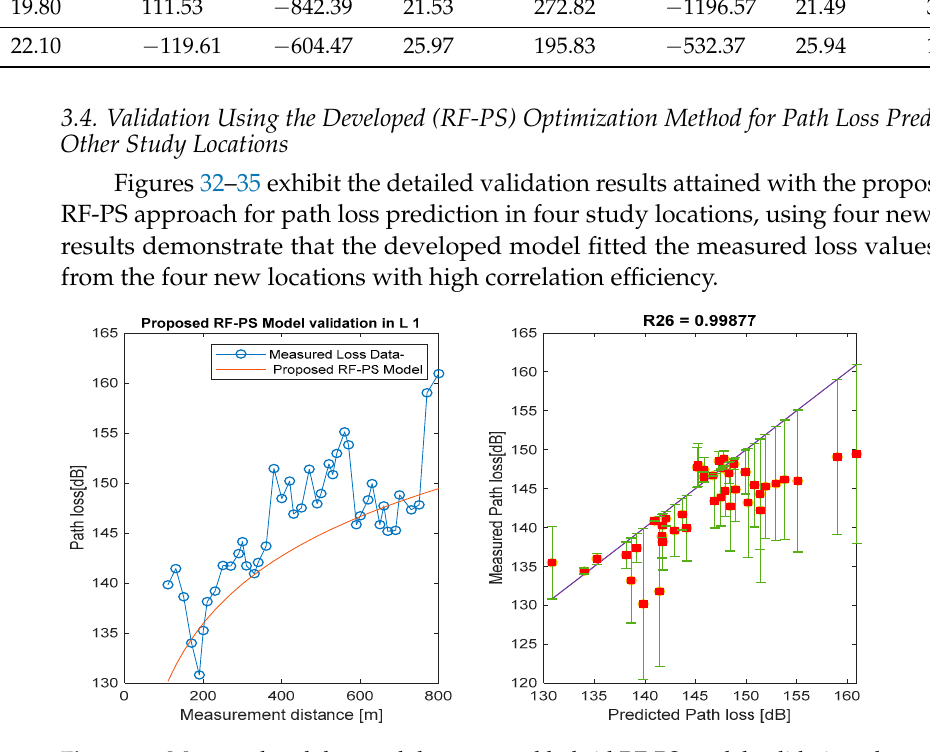
Figure 32. Measured path loss and the proposed hybrid RF-PS model validation plot using another site in location 1.